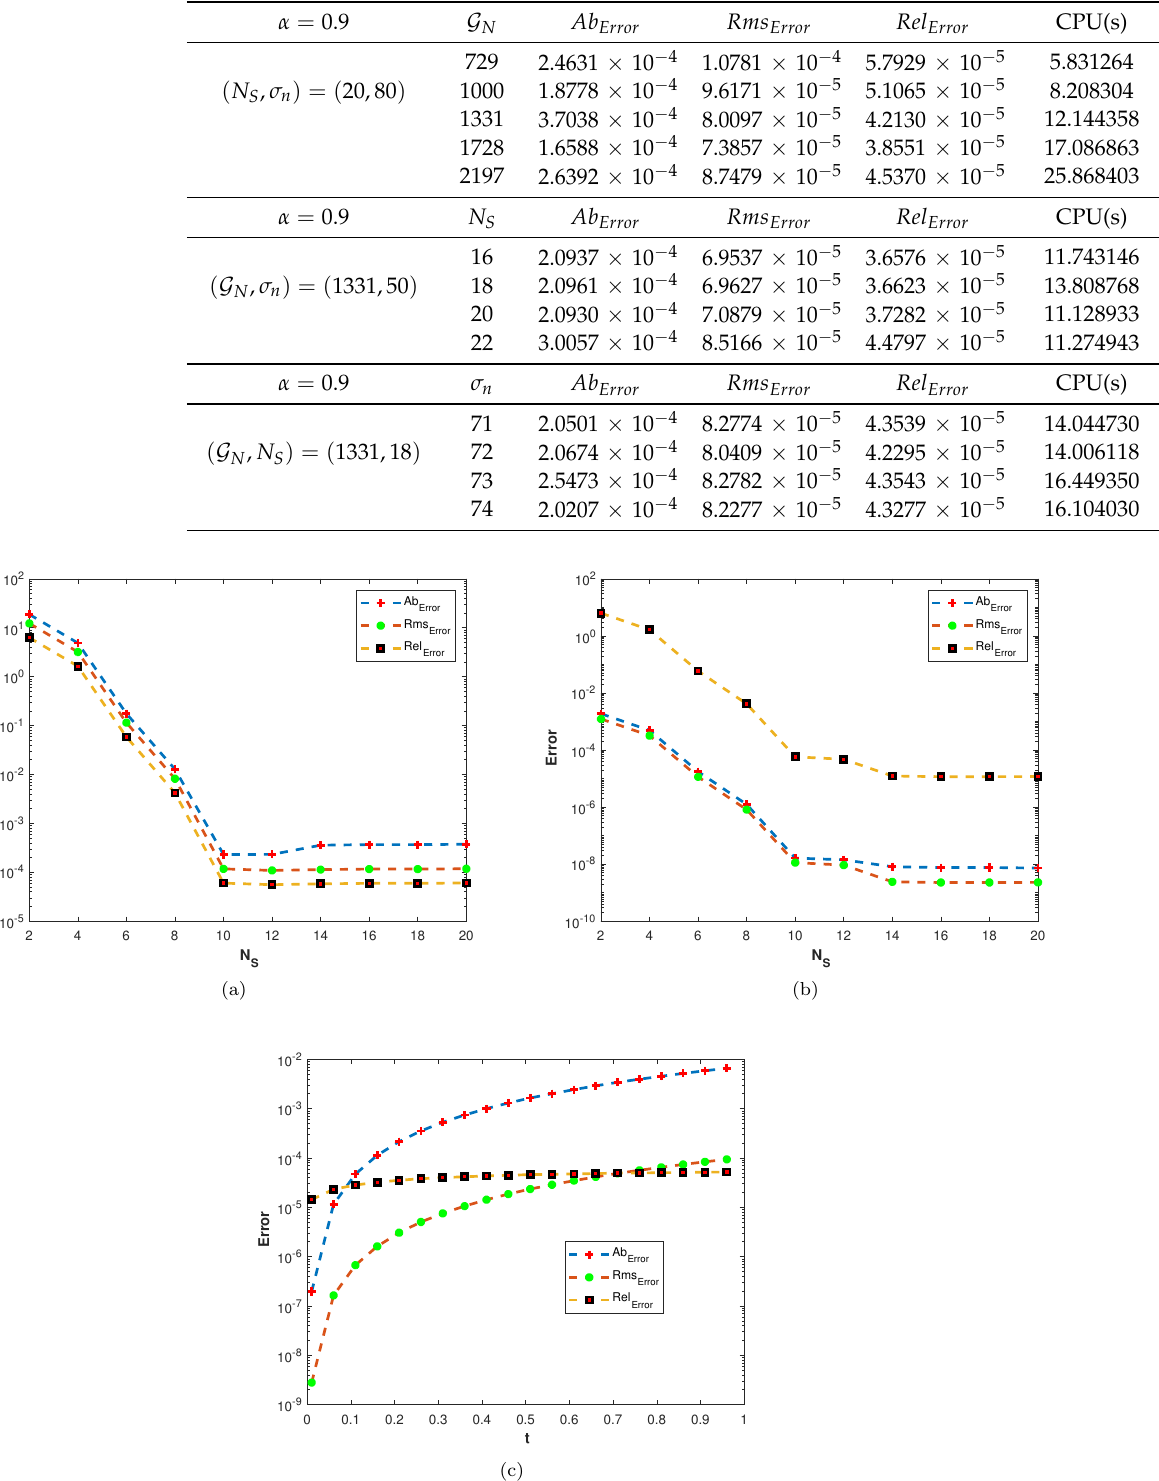
= 4913 , σ n = 80 at T = 1 . = 4913, σ n = 80 G N G N = 4096 , σ n = 80 at T = 0 . 01 . = 4096, σ n = 80 G N G N = 4913 , σ n = 80 , alpha=0.9, N S = 18. = 4913, σ n = 80, G N G N